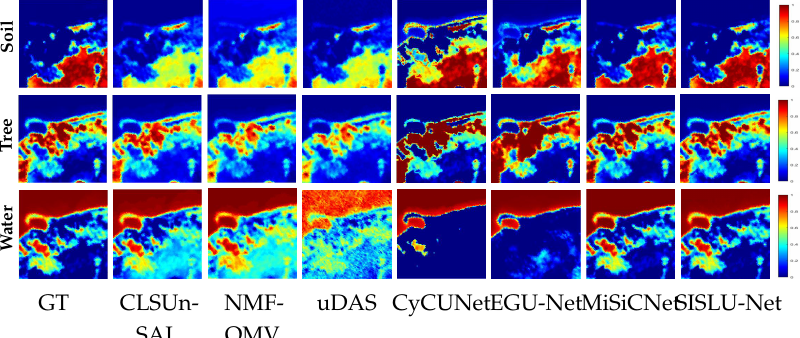
Figure 9. Estimated abundances by all competing methods on the Samson